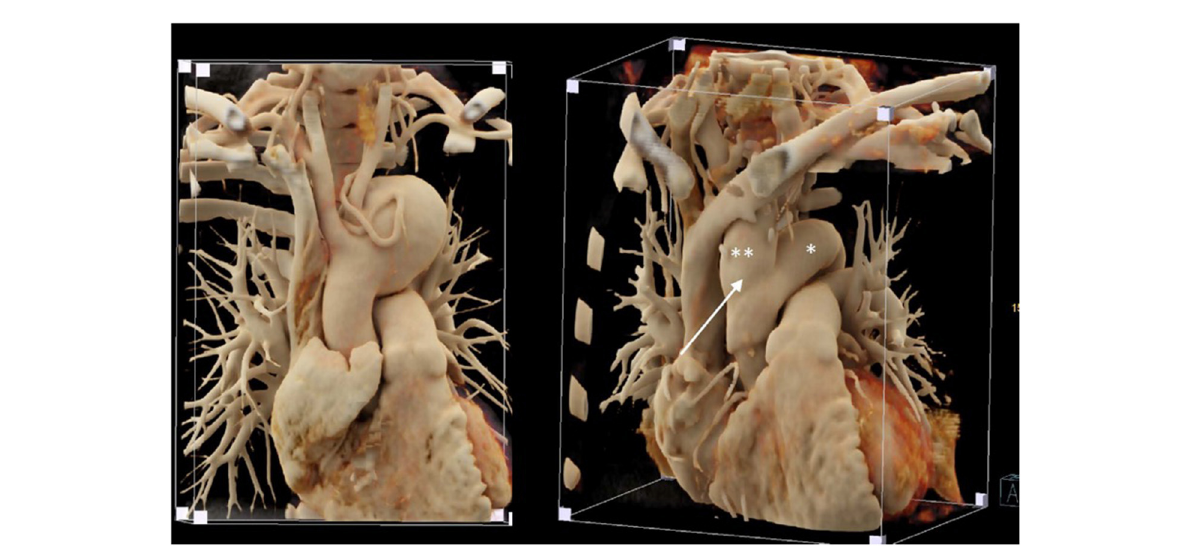
FIGURE9 Left: Huge aortic arch aneurysm in a patient with tuberous sclerosis; note the diminutive meandering left subclavian artery around the aneurysm. Right: Postoperative imaging following replacement of the ascending aorta and aortic arch with a 24 mm vascular graft (*) and a separate 20 mm